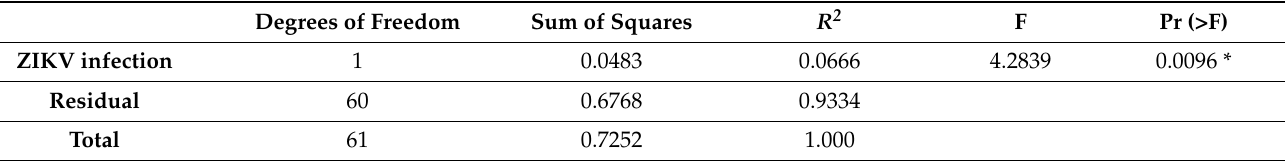
Table 1. Beta diversity analysis of Ae. aegypti midgut bacteria for ZIKV infection status using the Adonis2 test (* p < 0.05).